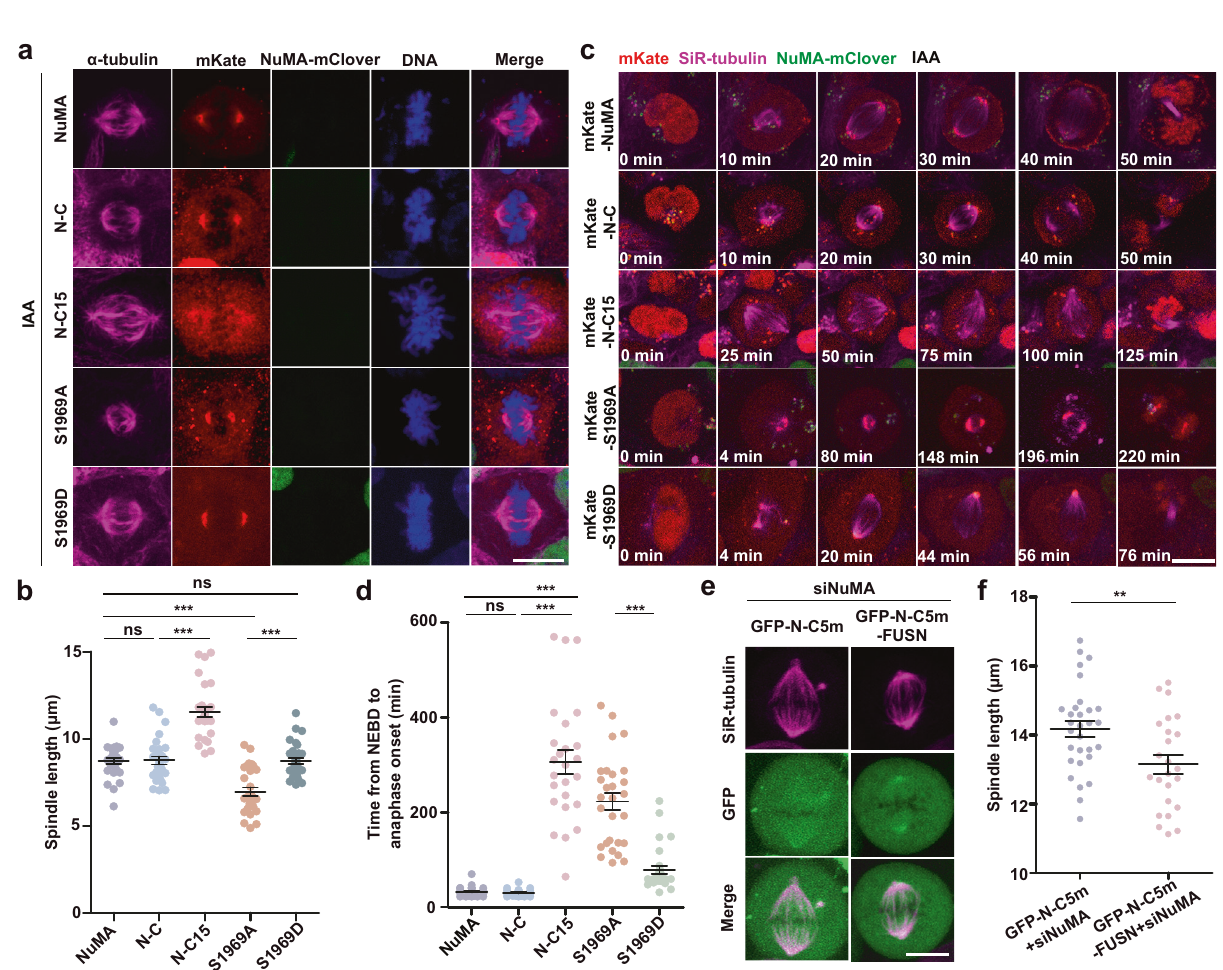
Fig. 7 Disrupting phase separation elongates spindle length. a Immuno fl uorescence images of mitotic spindles in endogenous NuMA-depleted NuMA- mACF cells stably expressing exogenous mKate-NuMA, mKate-N-C, mKate-N-C15, mKate-S1969A, and mKate-S1969D, followed by staining with anti- α - tubulin antibody and DAPI for DNA. b Quanti fi cation of spindle length in endogenous NuMA-depleted NuMA-mACF cells in a (mean ± SEM, n = 30 cells in 1 experiment, 3 independent experiments were repeated). Unpaired two-tailed t test: P = 0.8827 for NuMA/N-C, P < 0.0001 for N-C/N-C15, P < 0.0001 for NuMA/S1969A, P = 0.9691 for NuMA/S1969D, P < 0.0001 for NuMA-S1969A/NuMA-S1969D. c Time lapse of cell images showing the mitotic progress after rescuing different truncated mutants of NuMA upon endogenous NuMA depletion. d Quanti fi cation of the time from NEBD to anaphase onset of cells treated as in c (mean ± SEM, n = 30, 24, 25, 28, and 28 cells were measured for NuMA, N-C, N-C15, S1969A, and S1969D, respectively). Unpaired two-tailed t test: P = 0.2386 for NuMA/N-C, P < 0.0001 for N-C/N-C15, P < 0.0001 for NuMA/S1969A, P < 0.0001 for NuMA-S1969A/NuMA- S1969D. e Live cell images of mitotic HeLa cells expressed with GFP-N-C5m or GFP-N-C5m-FUSN after NuMA depletion. Microtubules were probed with SiR-tubulin. f Quanti fi cation of spindle length in e (mean ± SEM, n = 30, 24 cells were measured for N-C5m and N-C5m-FUSN in 1 experiment, 3 independent experiments were repeated). Unpaired two-tailed t test: P = 0.0055 for N-C5m/N-C5m-FUSN. ** P < 0.01, and *** P < 0.001, ns, not signi fi cant. Scale bars, 10 μ